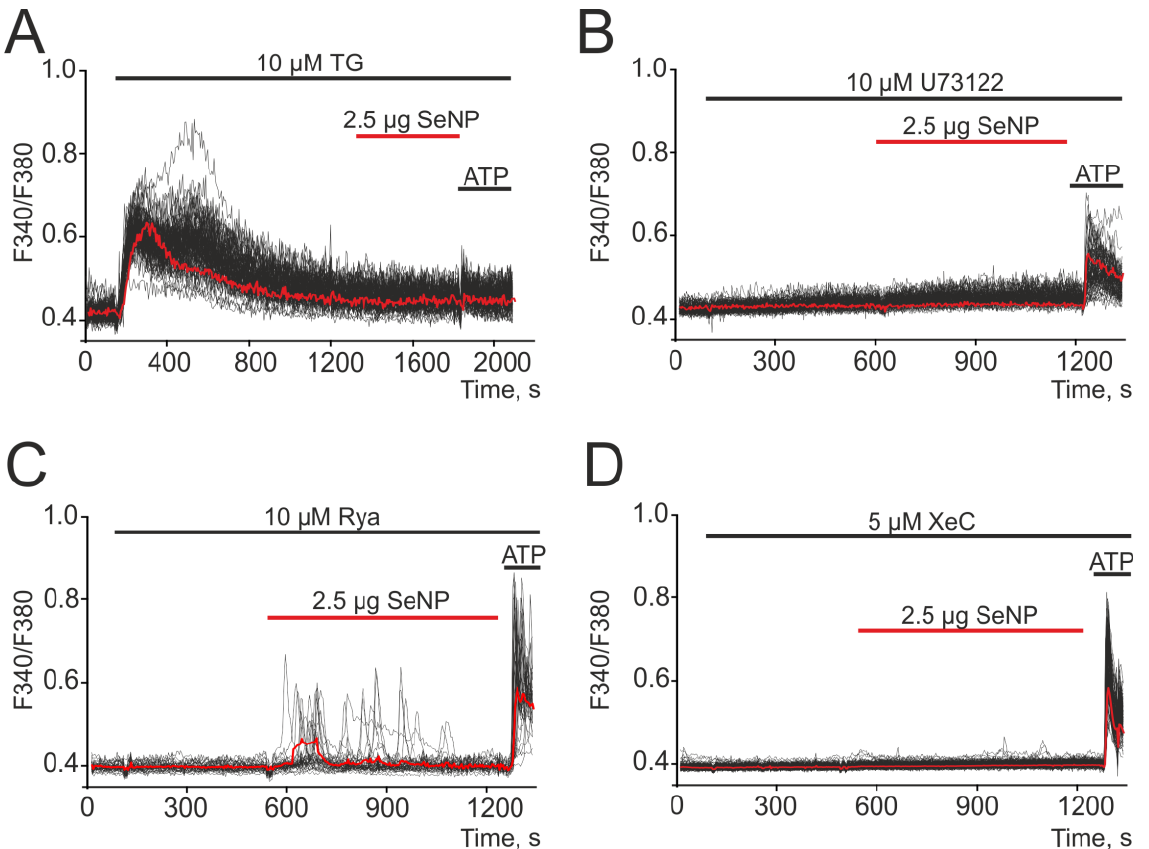
Figure 3. Generation of Ca 2+ signals in A-172 cells in response to the application of 2.5 μg/mL SeNP after depletion of the ER with Thapsigargin ( A , TG, 10 μM), in the presence of 10 μM ( B ) of PLC inhibitor—U73122, antagonists of ryanodine ( C , ryanodine, Rya, 10 µM) and IP3 receptors ( D , Xestospongin C, XeC, 5 µ M). At the end of the experiment, 10 µ M adenosine triphosphate (ATP) was added. Here, Ca 2+ signals of cells in one experiment and their and their average value (red curve) are presented.